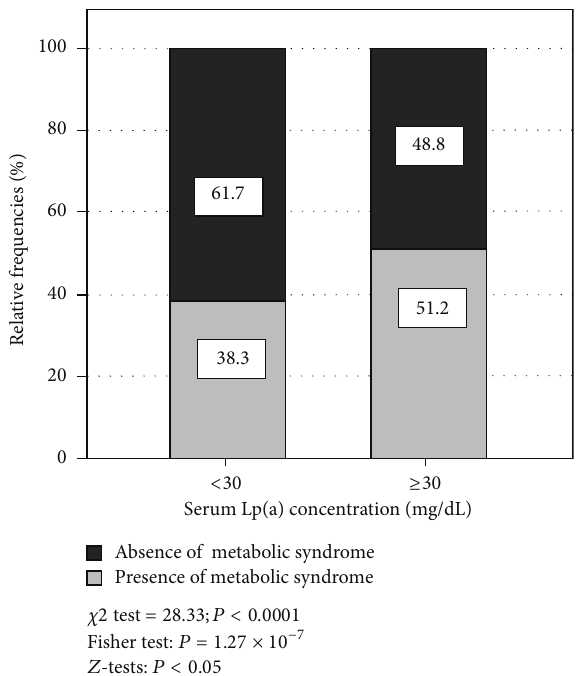
Figure 1: Distribution of subjects by Lp(a) categories and diagnosis of metabolic syndrome. The Maracaibo City Metabolic Syndrome Prevalence Study,